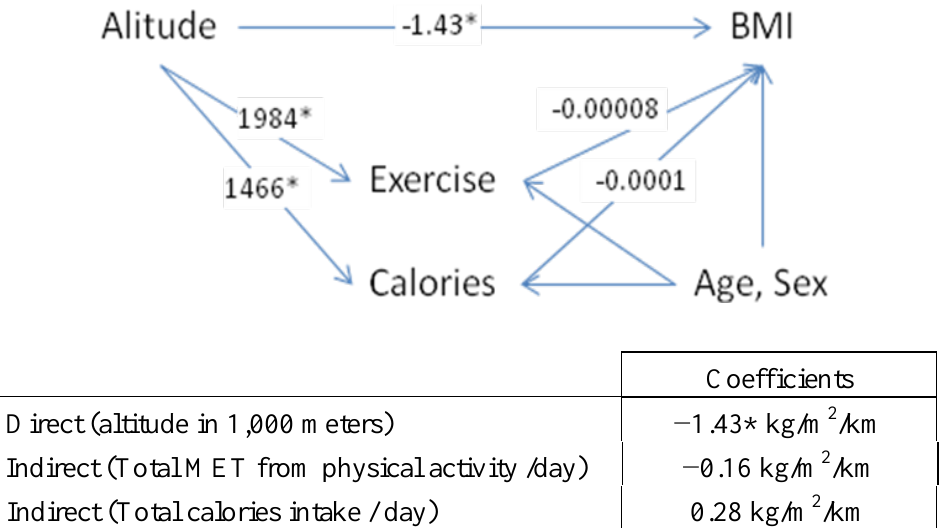
Figure 2. Path diagram for the effect of altitude on body mass index